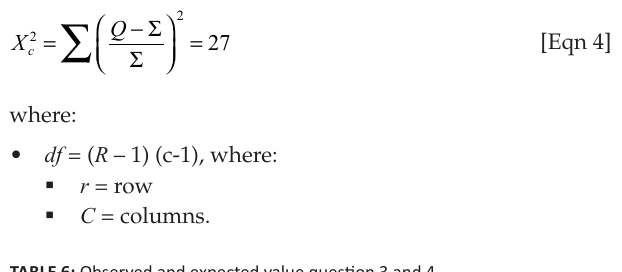
TABLE 6: Observed and expected value question 3 and 4.